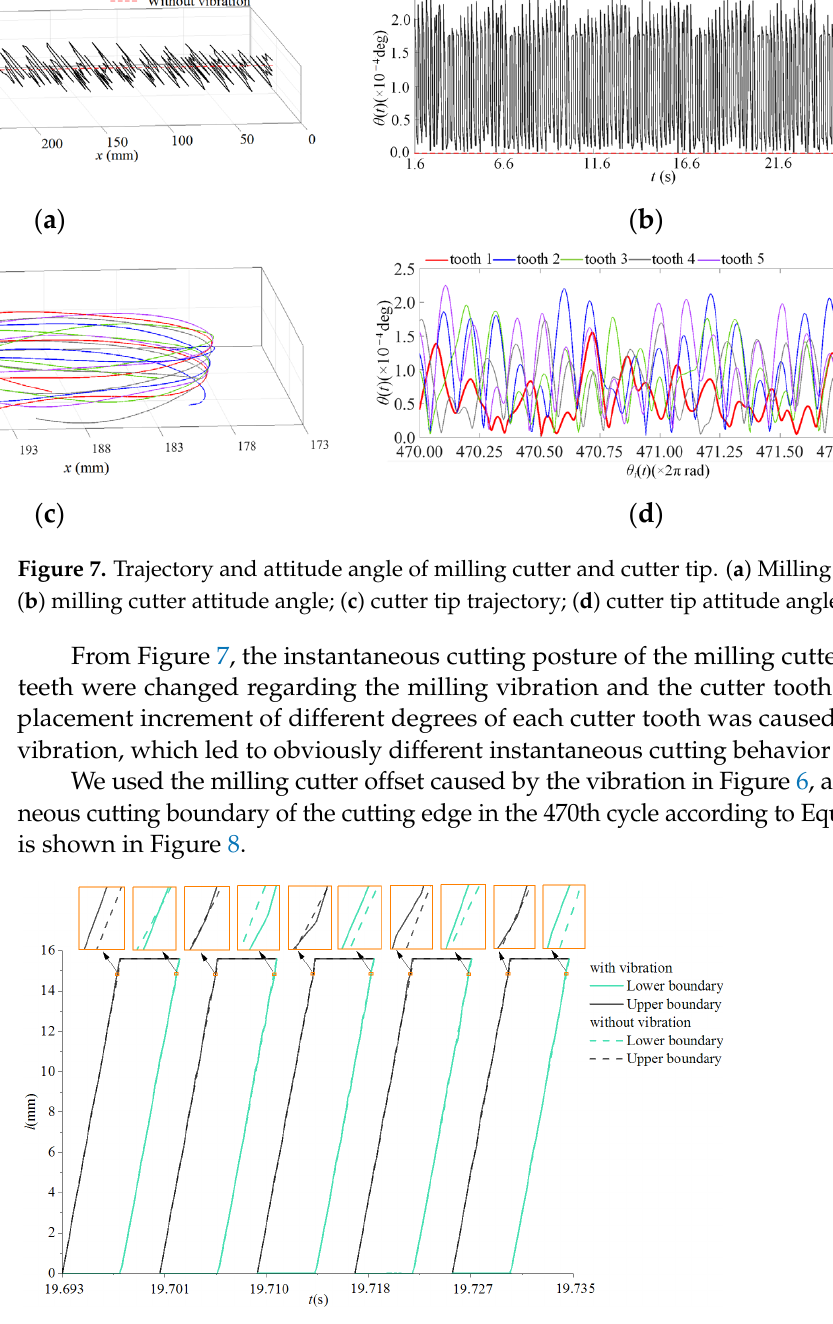
Figure 8. Instantaneous cutting boundary of the cutting edge.